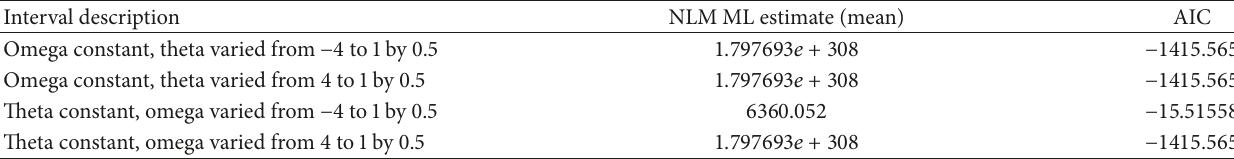
Table 7: Summary of results for lambda = 0.1, 𝑛 = 10 𝑖 , 𝑖 = 4 .